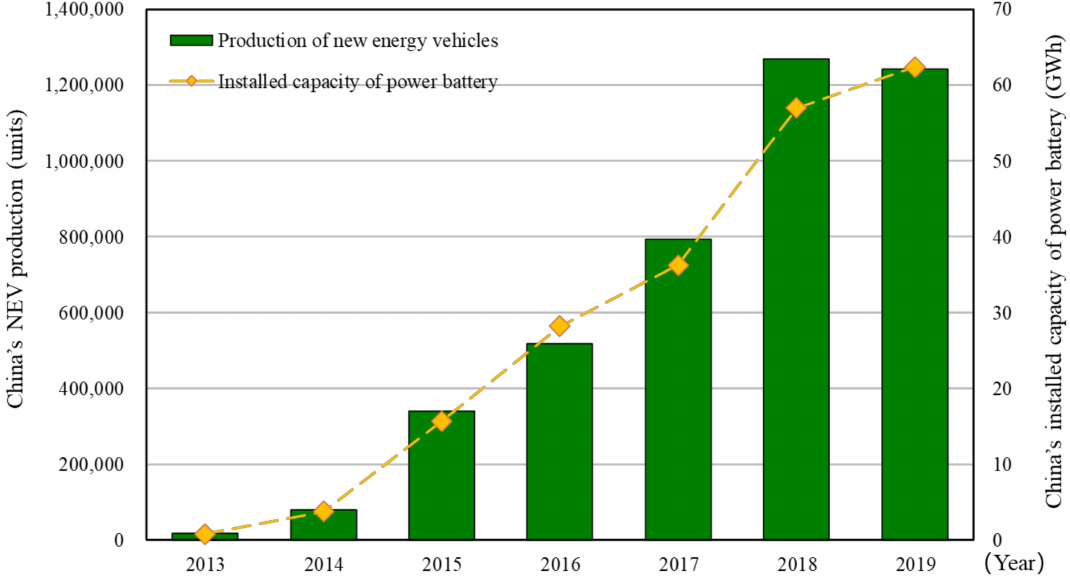
Figure 1. Production of new NEVs (new energy vehicles) and installed capacity of power batteries in China